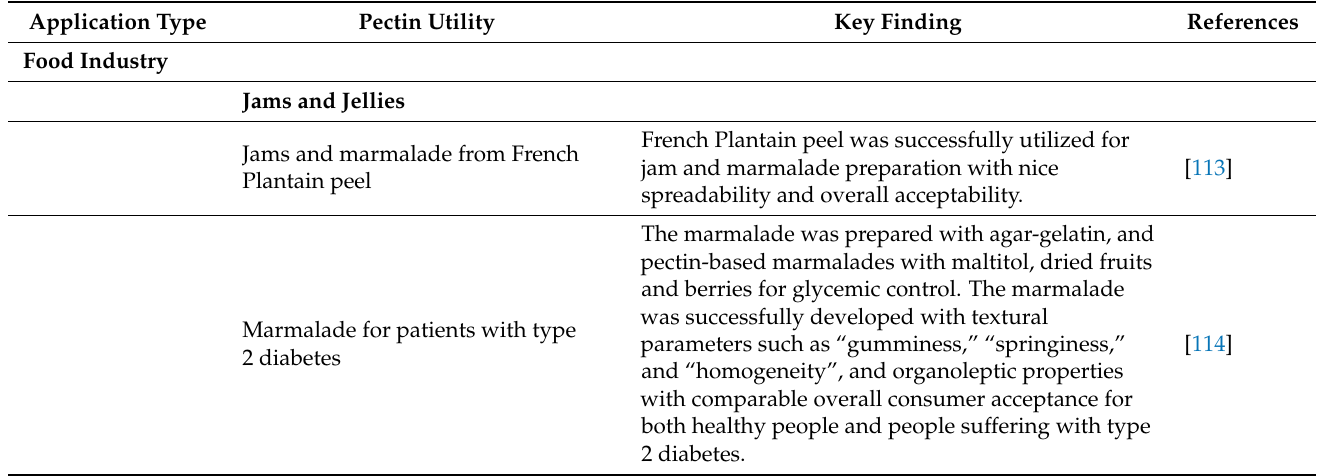
Figure 2. Multifunctional applications of pectin. Table 2. Pectin utility and application potential.